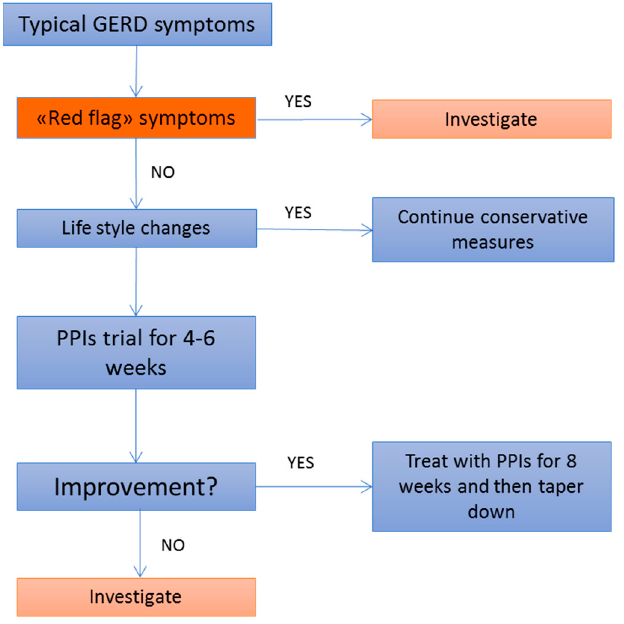
Figure 2. Flowchart of the clinical management of GERD in older children and adolescents [11]. PPIs: proton pump inhibitors.